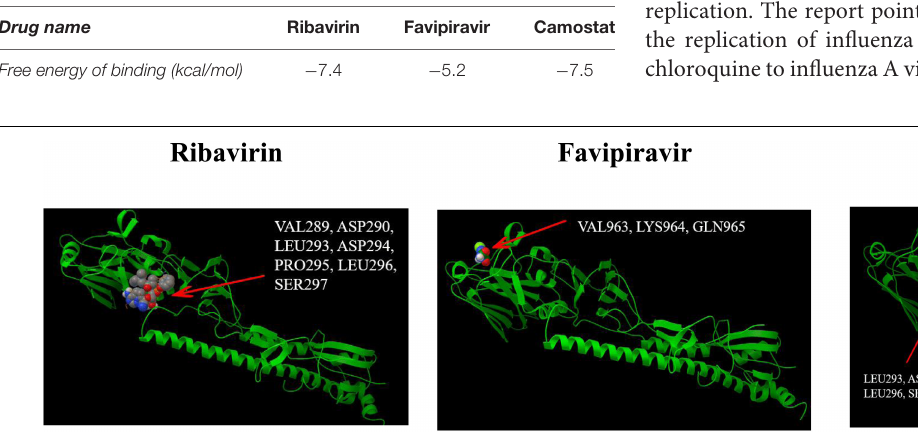
Frontiers in Physiology |